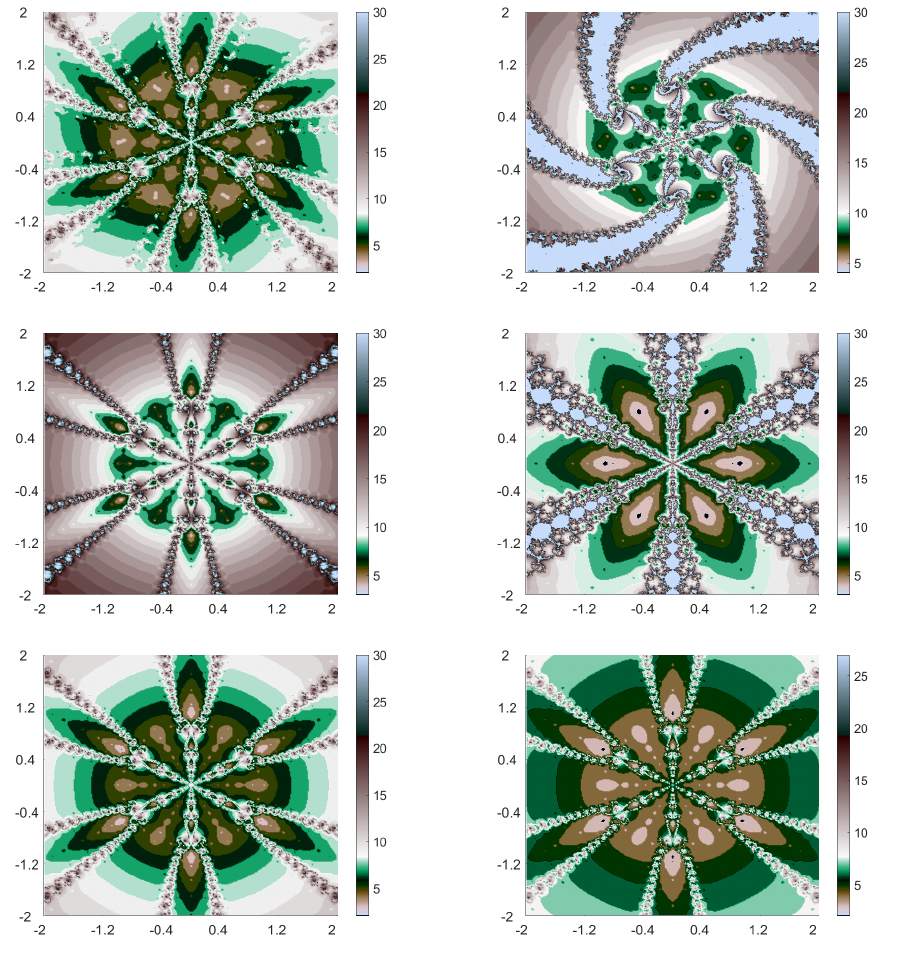
Figure 1. Visualisation of polynomiographs by various methods for p ( z ) = z 6 − 1: RK iteration ( Top Left ); RK iteration with s-convexity ( Top Right ); Mann iteration ( Middle Left ); Ishikawa itera- tion ( Middle Right ); S-iteration ( Bottom Left ), and Picard–Mann iteration ( Bottom Right